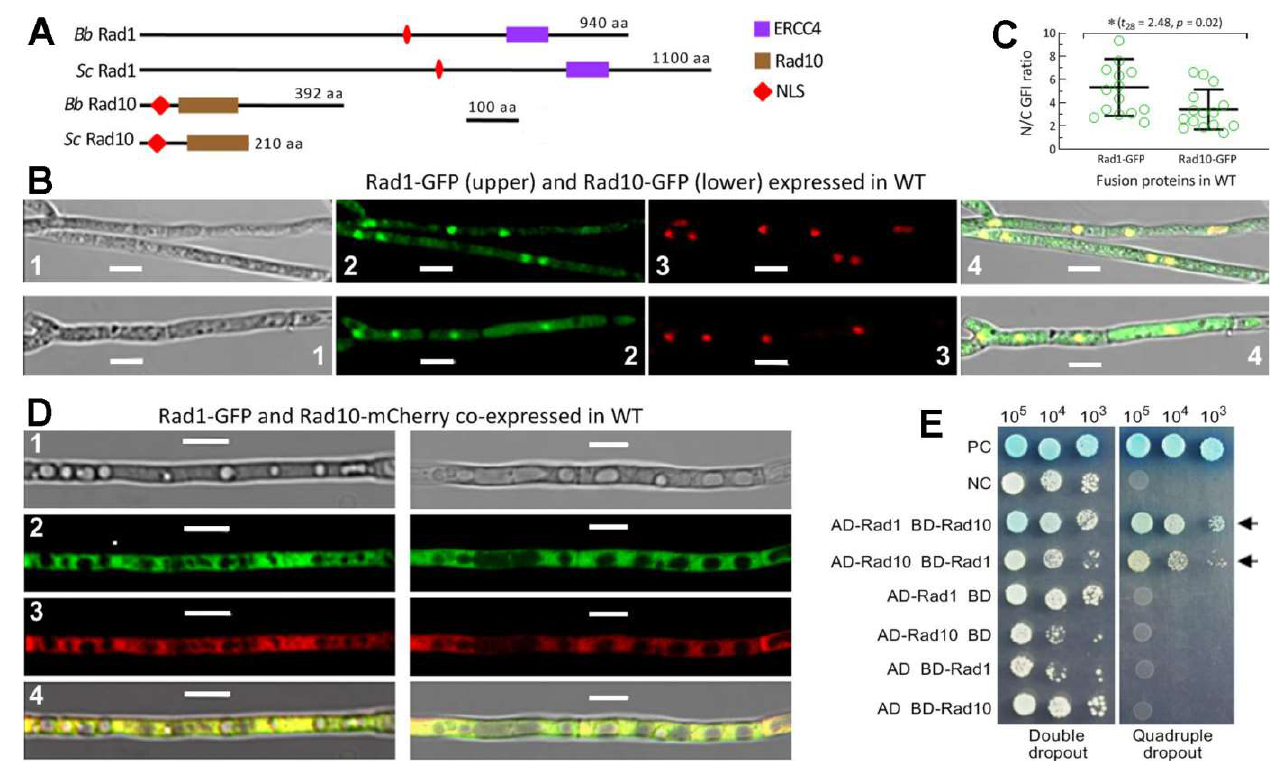
Figure 1. Domain architecture, subcellular localization, and interaction of Rad1 and Rad10 in B. bassiana . ( A ) Comparison of conserved domains and NLS motifs predicted from the amino acid sequences of Rad1 and Rad10 orthologues in B. bassiana ( Bb ) and S. cerevisiae ( Sc ). ( B ) LSCM images (scale bars: 5 µ m) for subcellular localization of Rad1-GFP and Rad10-GFP fusion proteins expressed in the 3 d-old SDBY cultures of a Bb wild-type (WT) strain at 25 ◦ C and L:D 12:12 and stained with the nuclear dye DAPI (shown in red). Images 1–4 are bright, expressed, stained, and merged views of the same microscopic field, respectively. ( C ) The ratios of nuclear versus cytoplasmic green fluorescence intensities (N/C-GPI) of Rad1-GFP and Rad10-GFP assessed from the 15 hyphal cells of the cultures. * p = 0.02 in Student’s t test. ( D ) LSCM images (scale bars: 5 µ m) for subcellular localization of Rad1-GFP (image 2) and Rad10-mCherry (image 3) fusion proteins co-expressed in the WT strain. ( E ) Y2H assay for an interaction between Bb Rad1 and Bb Rad10. The diploids AD-Rad1-BD-Rad10 and AD-Rad10-BD-Rad1 (arrowed) grew well like the positive control (AD-LargeT-BD-P53) on the quadruple-dropout medium during a 3-day incubation at 30 ◦ C after initiation of colony growth by 10 3 , 10 4 , and 10 5 cells.